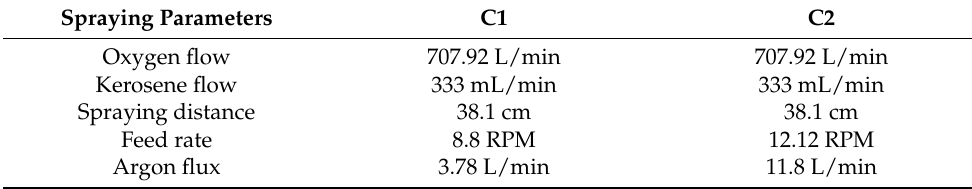
Figure 2. Cross-section of ( a ) C1 coating and ( b ) C2 coating. Table 1. HVOF Spraying parameters.